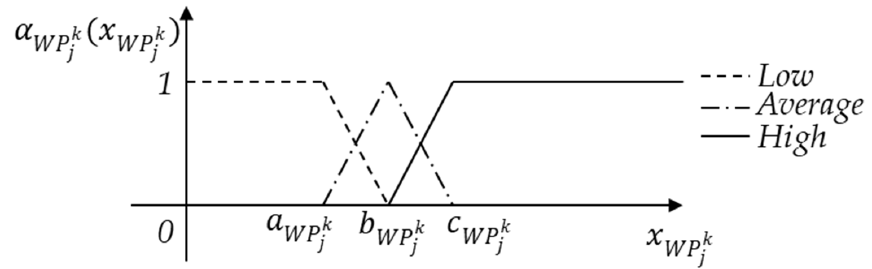
Figure 2. The membership function of the linguistic variable of the sorting point efficiency.